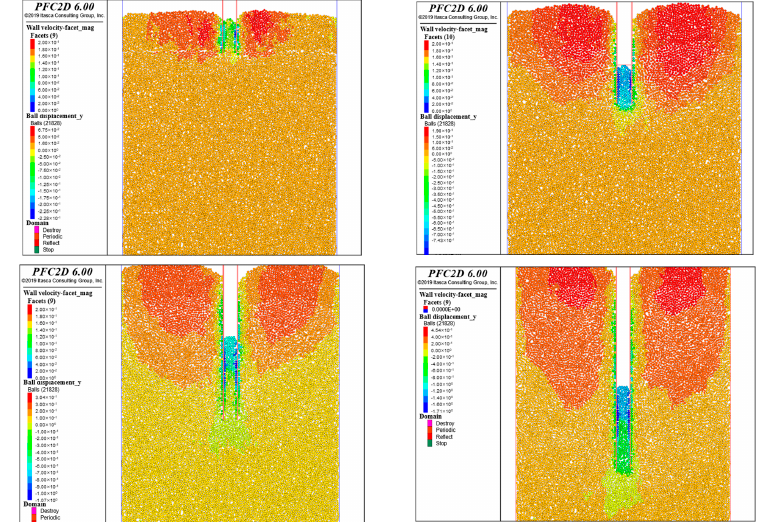
Figure 7. Simulation results of condition a .